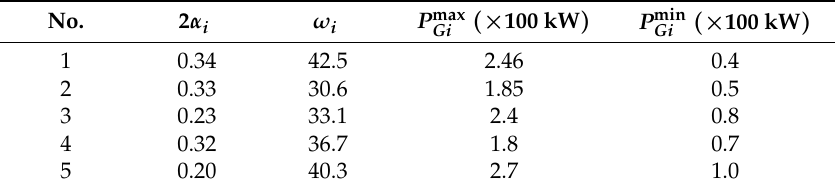
Table 6. Parameters of users’ demand function.